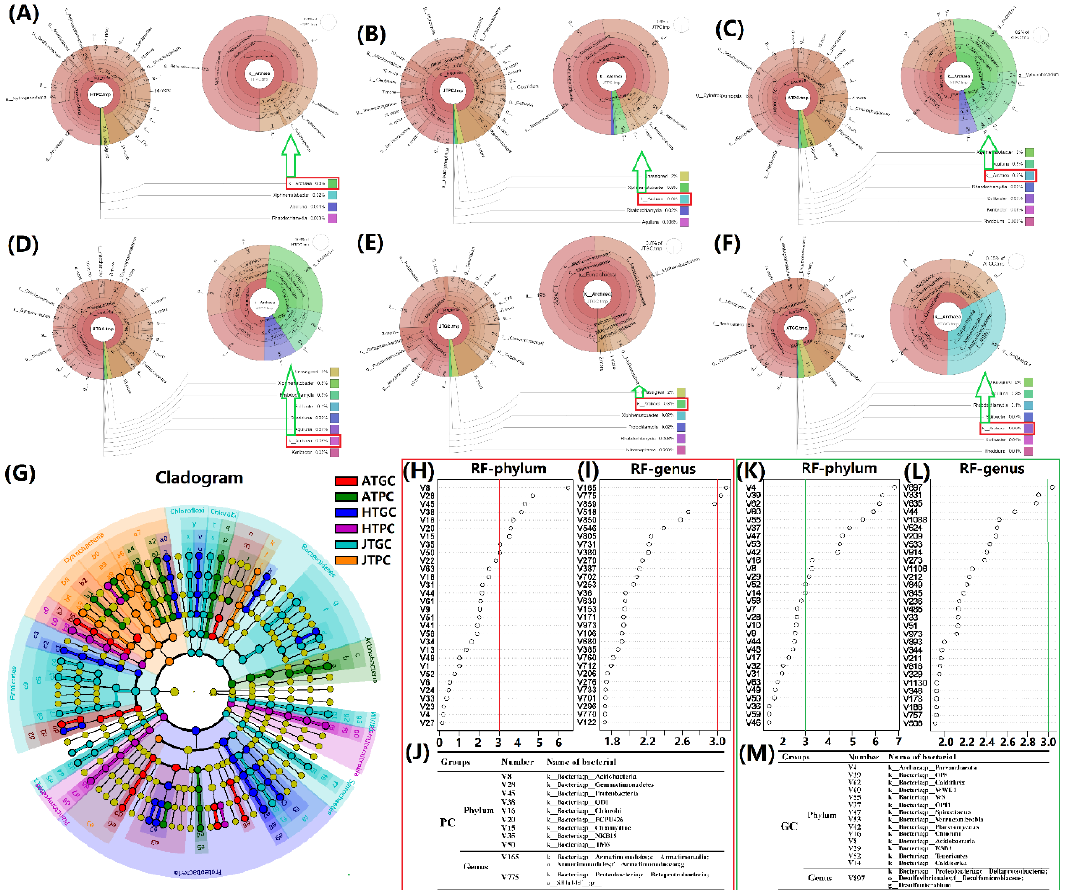
Figure 3. Bacterial and Archaea, LEfSe analysis and random forest model of different classifications annotation of the freshwater turtle C. reevesii in six groups. ( A – F ): HTPC group, JTPC group, and ATPC group, HTGC group, JTGC group, and ATGC group. The circles represent different classification levels from inside to outside, and the size of the fan represents the relative proportion of different OTU annotation results. The group level was constituted by the average level of relative abundance of each species in each group ( n = 3 or 4); ( G ): LEfSe cladogram, the circle radiating from the inside to the outside represents the classification level from the phylum to the genus (the innermost yellow circle is the Kingdom). Each small circle at a different classification level represents a classification at their levels, and the diameter of the circle represents the relative abundance; ( H - M ): random forest model maps of PC and GC in phylum and genus level based on MDA algorithm.